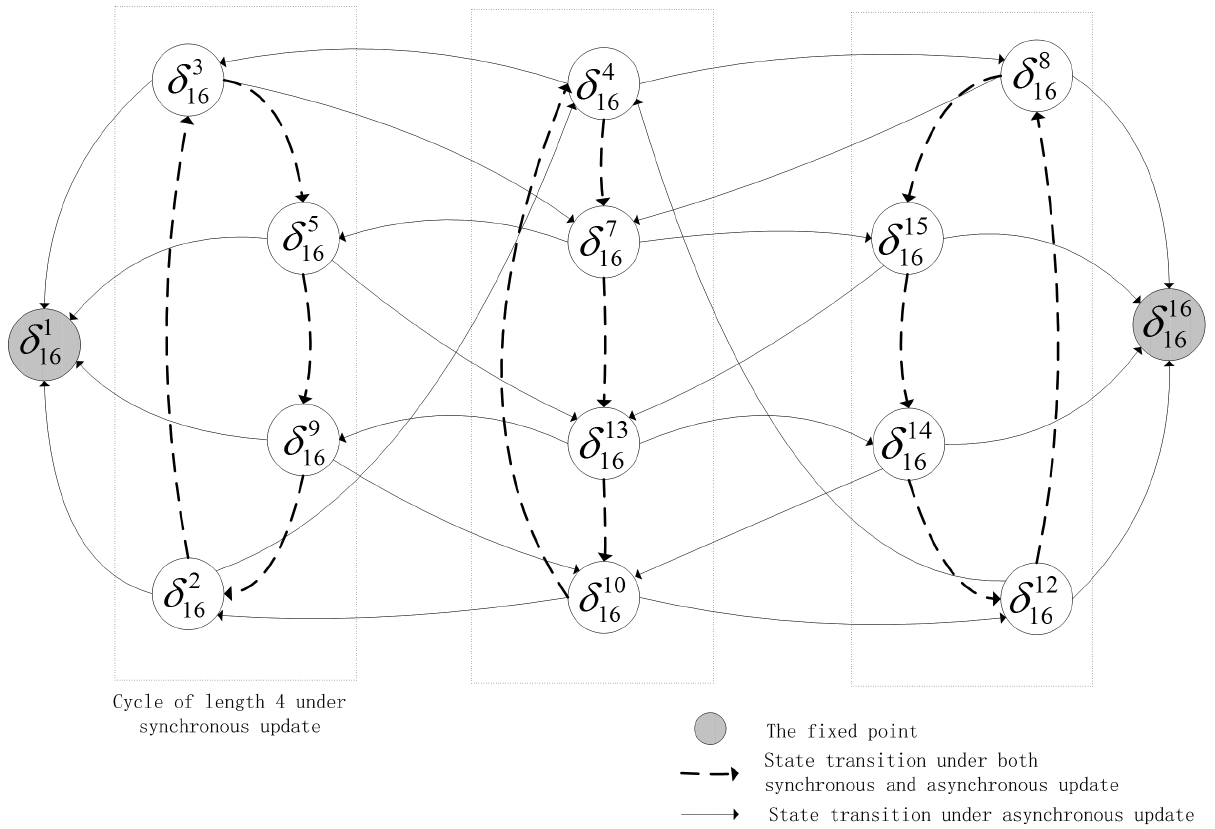
Figure 2. State transfers (Including two fixed points and the former cycles of length four).